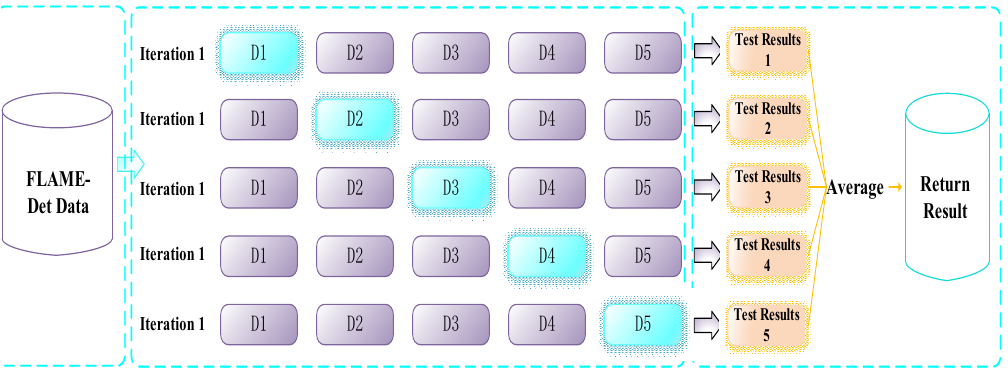
Figure 10. Schematic diagram of the five-fold cross-validation process.